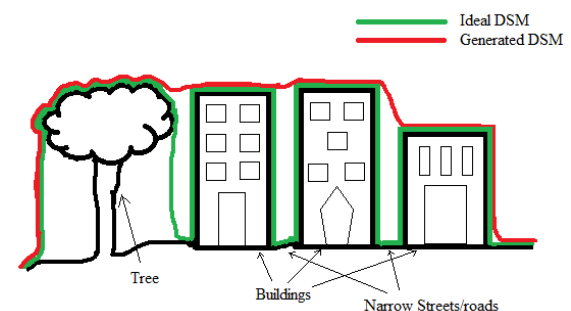
Figure 2. Pictorial representation of DSM generated from photogrammetric process (Red line) and the ideal DSM how the surface is present (Green